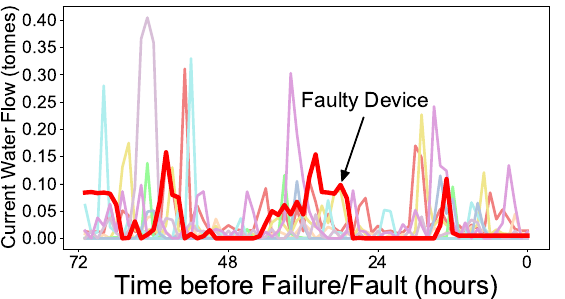
Figure 1. Example of current water flow (consumption) of faulty (bold red) and healthy RWMR devices (other colors) prior to